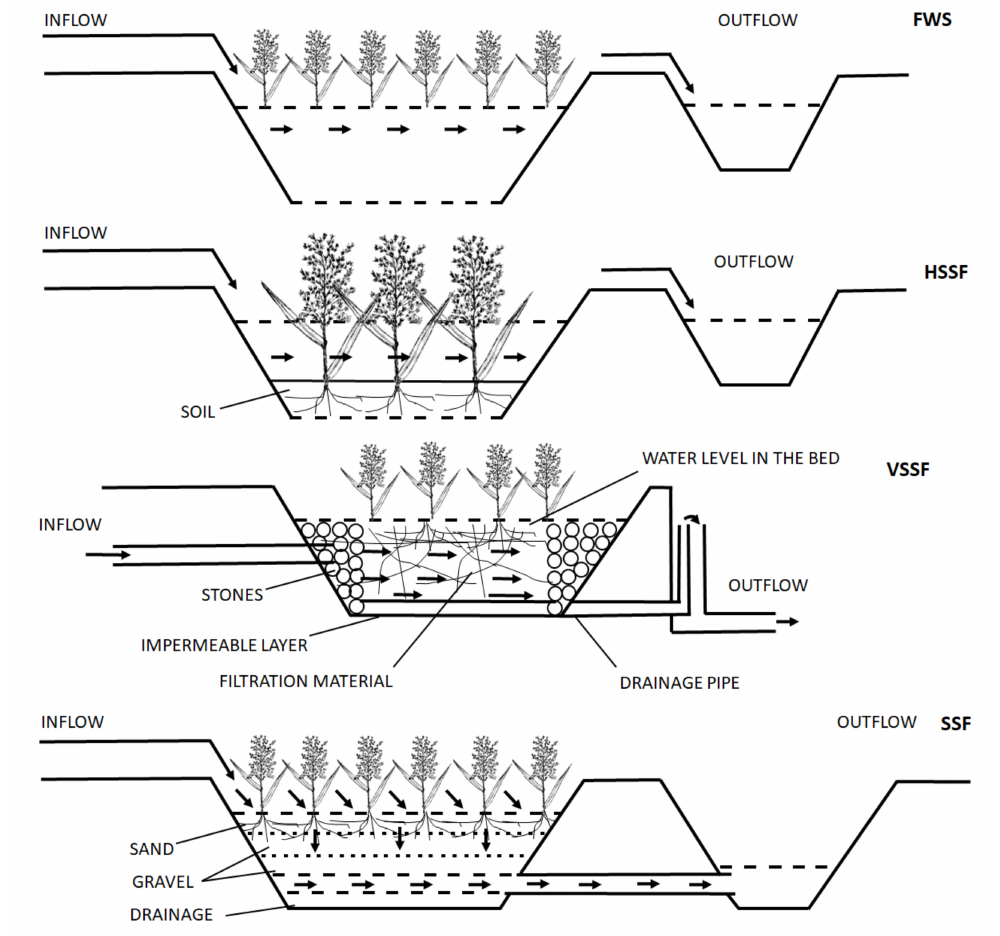
Figure 1. Types of flows in constructed